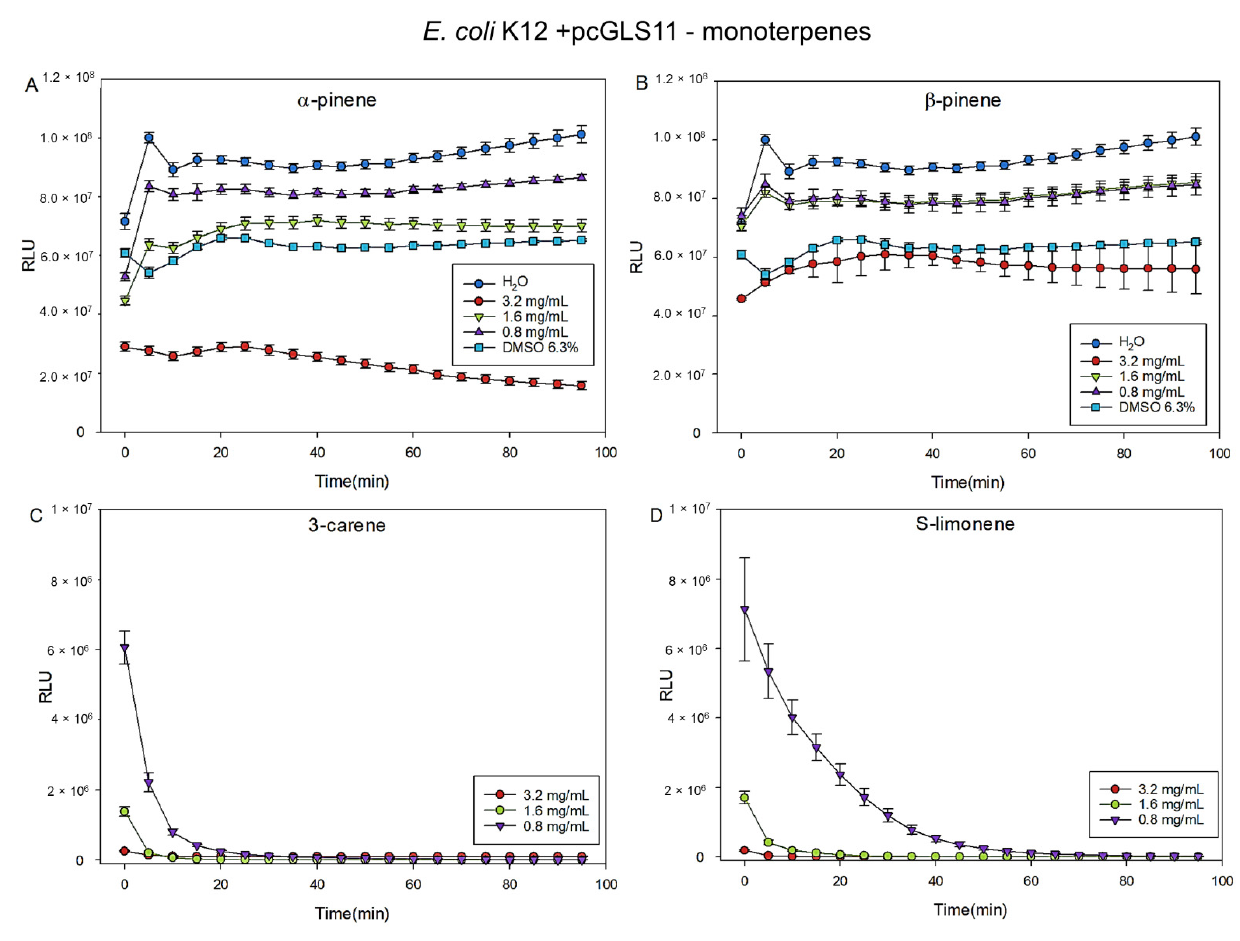
Figure 6. Effect of the monoterpenes ( A ) α -pinene, ( B ) β -pinene, ( C ) 3-carene, and ( D ) S-limonene for the viability of continuously luminescent light producing biosensor strain E. coli K12+pcGLS11. The highest content of DMSO 6.3% found in the highest concentration (3.2 mg/mL) of monoterpenes is drawn as a control in A and B. The figure shows the relative light unit (RLU) averages of the triplicates in the microplate. Lower the RLU aka light production values, the more efficient the terpene in question is in inhibiting the bacterial metabolism, which indicates antibacterial activity. The error bars represent the standard deviations of the sample triplicates.